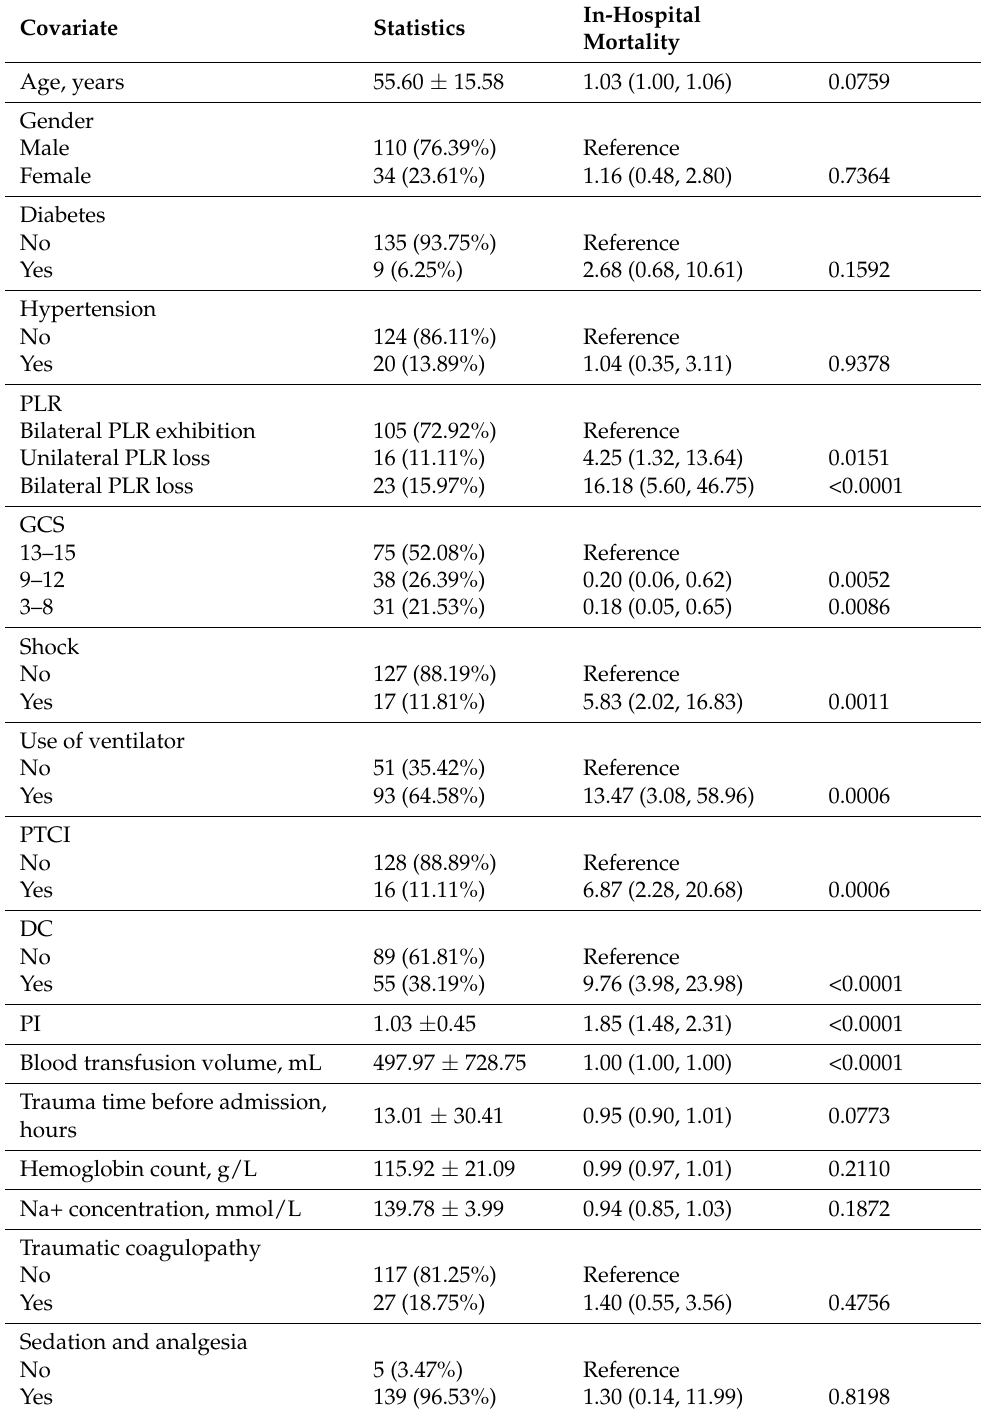
Table 2. Univariate analysis for in-hospital